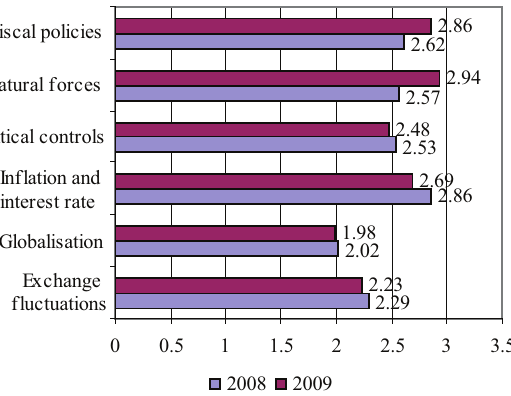
figure 2. Impact assessment of external project